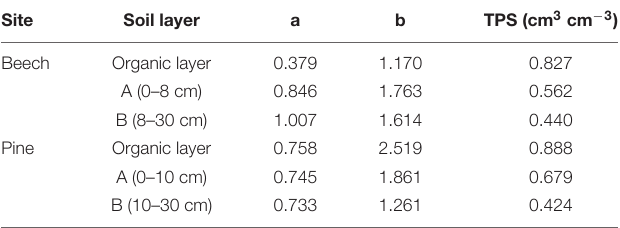
TABLE 2 | Measured values of total pore space (TPS) and fitted parameters (a, b) to calculate the relative diffusion coefficient ( D r ) as a function of AFPS for the two sites and the soil horizons according to Eq.